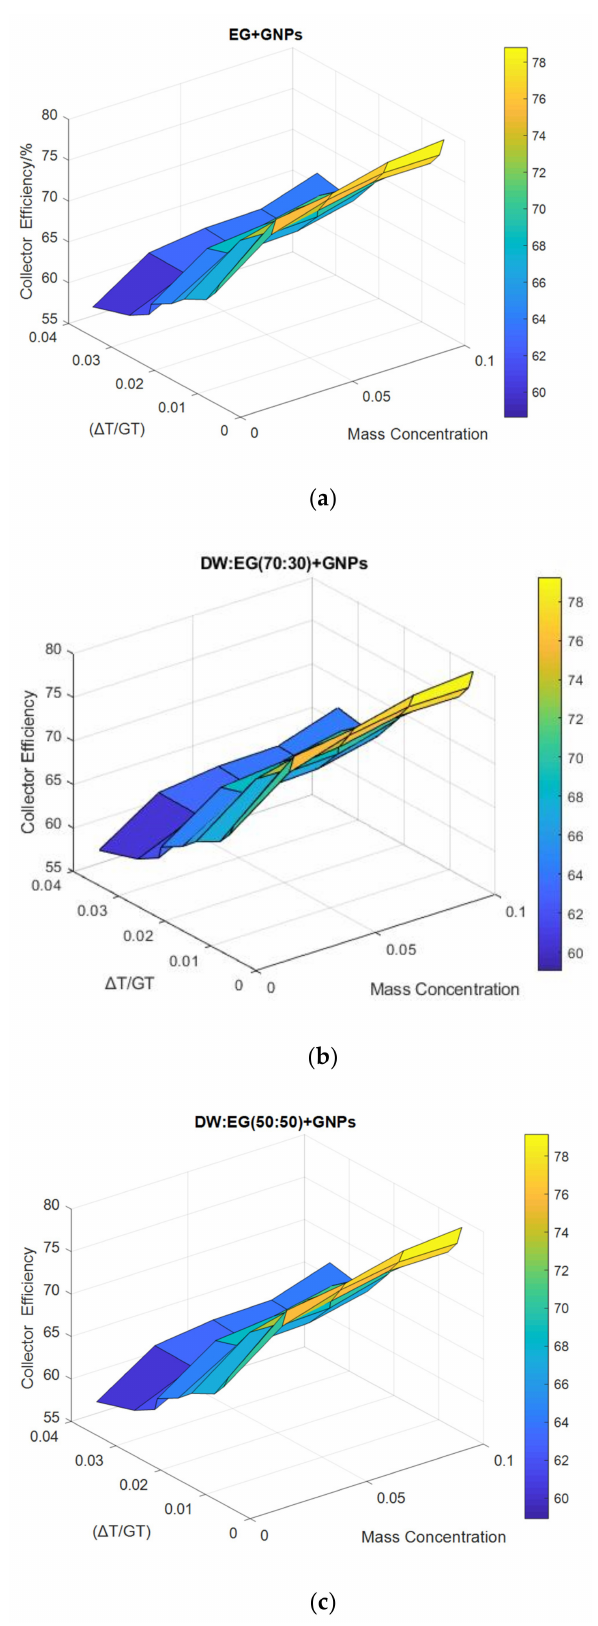
Figure 13. The surface plots of collector efficiency against mass concentration and reduced tempera- ture factor at 1.5 kg min − 1 : ( a ) EG + GNPs, ( b ) DW:EG (70:30) + GNPs, ( c ) DW:EG (50:50) +